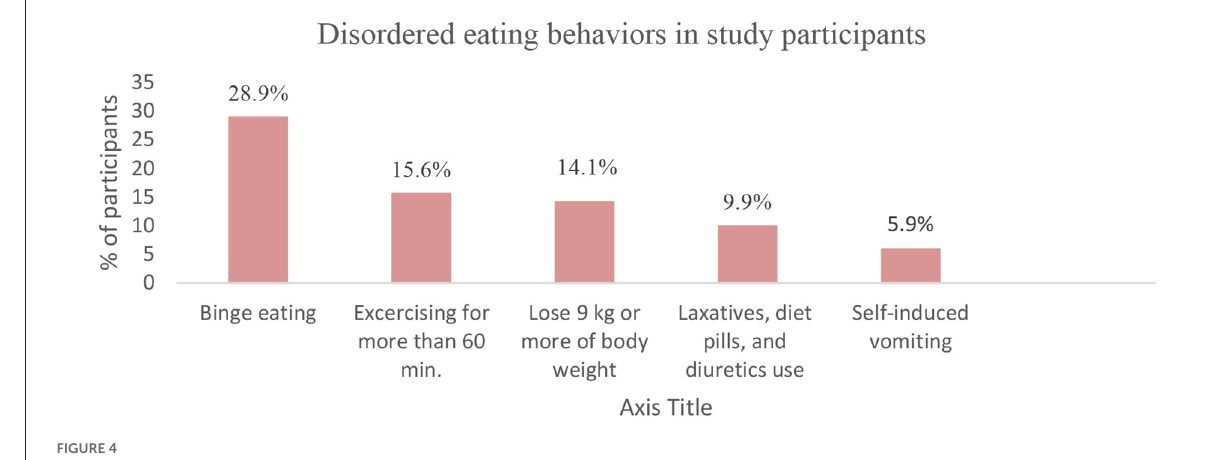
FIGURE4 Eating behaviors across risk